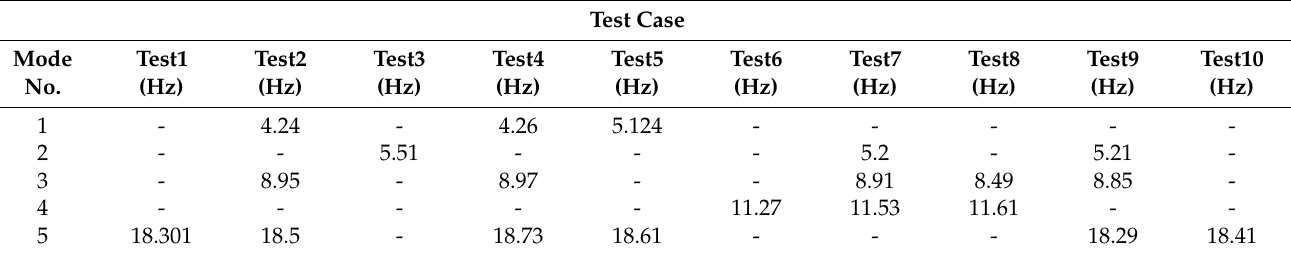
Table 4. Extracted natural frequencies using the SSI method.